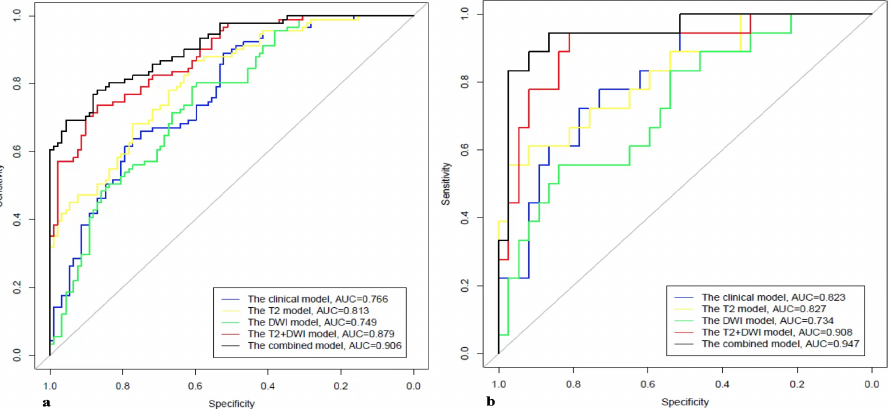
Figure 3. The AUCs of different models in the training ( a ) and test ( b ), respectively. Table 3. The selected radiomics features of T2WI, DWI, and T2WI + DWI models. Table 4. The diagnostic performance of models. Radiomics